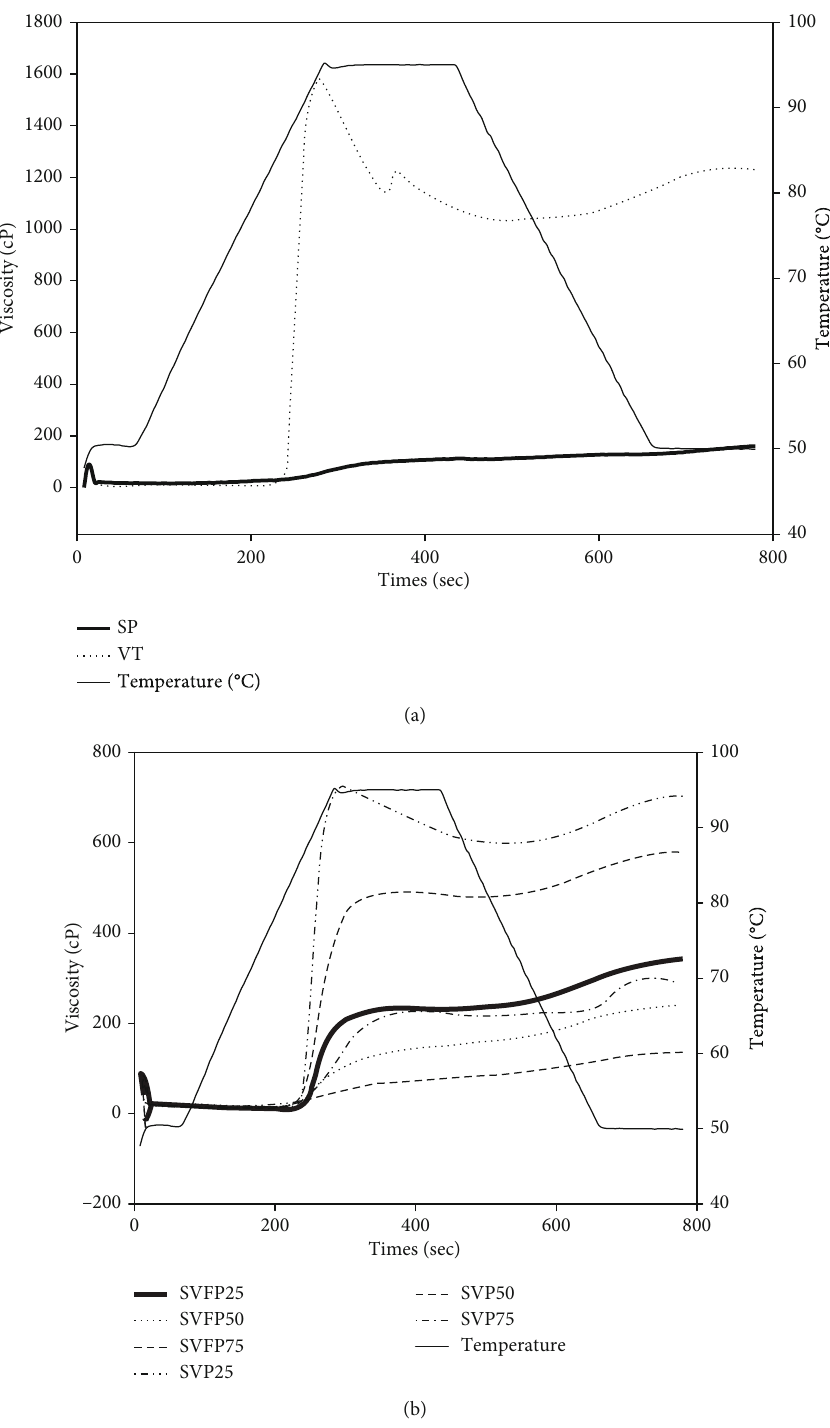
Figure 4: Pasting properties of precooked sorghum and Bambara groundnut fl our (a) and blended precooked and fermented fl our (b). SP: precooked dehulled sorghum fl our; VT: roasted dehulled Bambara fl our; SVP25: blended fl our containing 25% of precooked sorghum fl our and 75% of roasted Bambara fl our; SVP50: blended fl our containing 50% of precooked sorghum fl our and 50% of roasted Bambara fl our; SVP75: blended fl our containing 75% of precooked sorghum fl our and 25% of roasted Bambara fl our; SVFP25: fermented fl our containing 25% of precooked sorghum fl our and 75% roasted Bambara fl our; SVFP50: fermented fl our containing 50% precooked sorghum fl our and 50% roasted Bambara fl our; SVFP75: fermented fl our containing 75% precooked sorghum fl our and 25% roasted Bambara fl